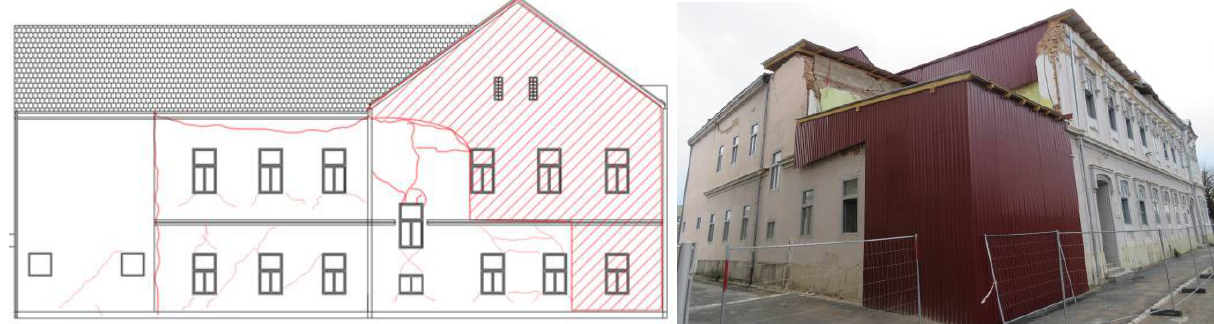
Figure 11. Northwestern façade plan with marked damage.